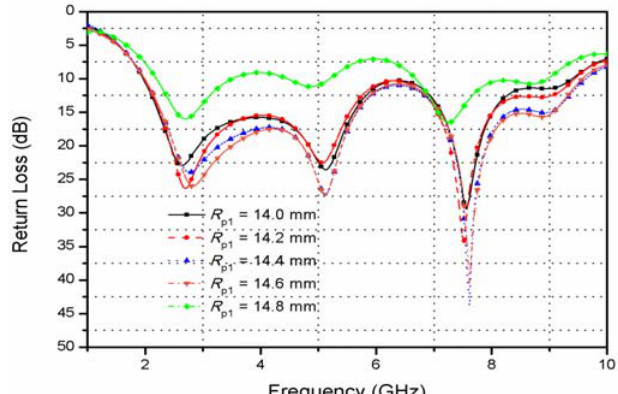
Figure 3: Simulated return loss against frequency for the octagonal ring shape ultra wideband antenna with various : other parameters are the same as listed in Table 1. R p1